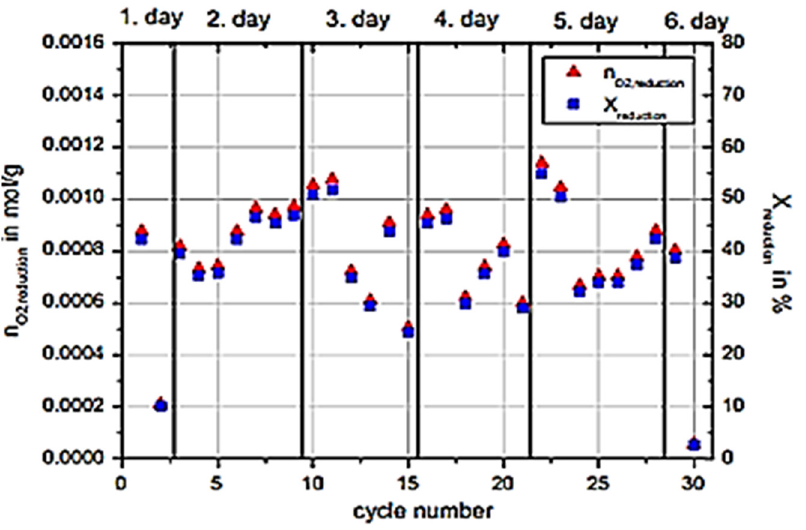
Figure 8. Amount of oxygen per mol of Co 3 O 4 and conversion during reduction [111].